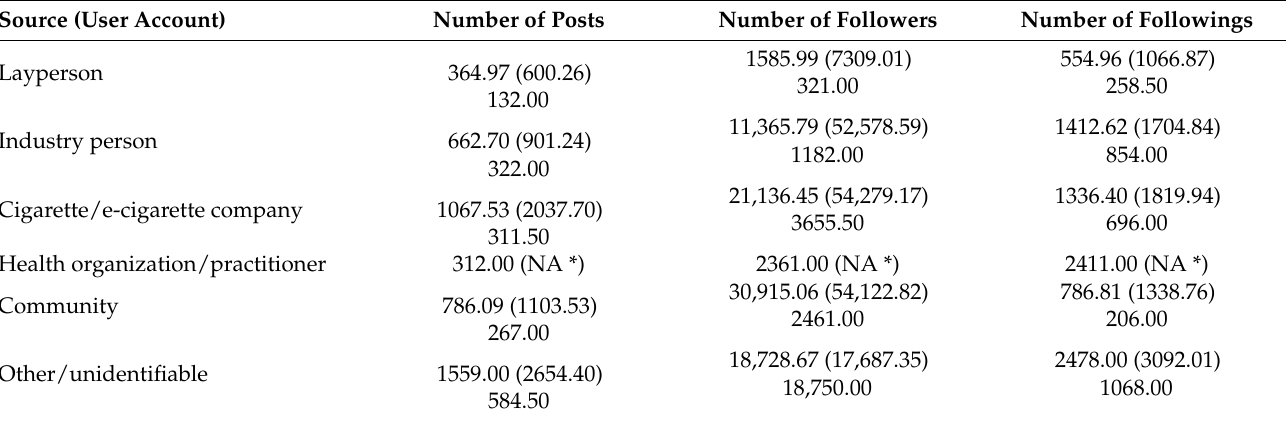
Table 3. Account activities according to source type (mean (standard deviation) and